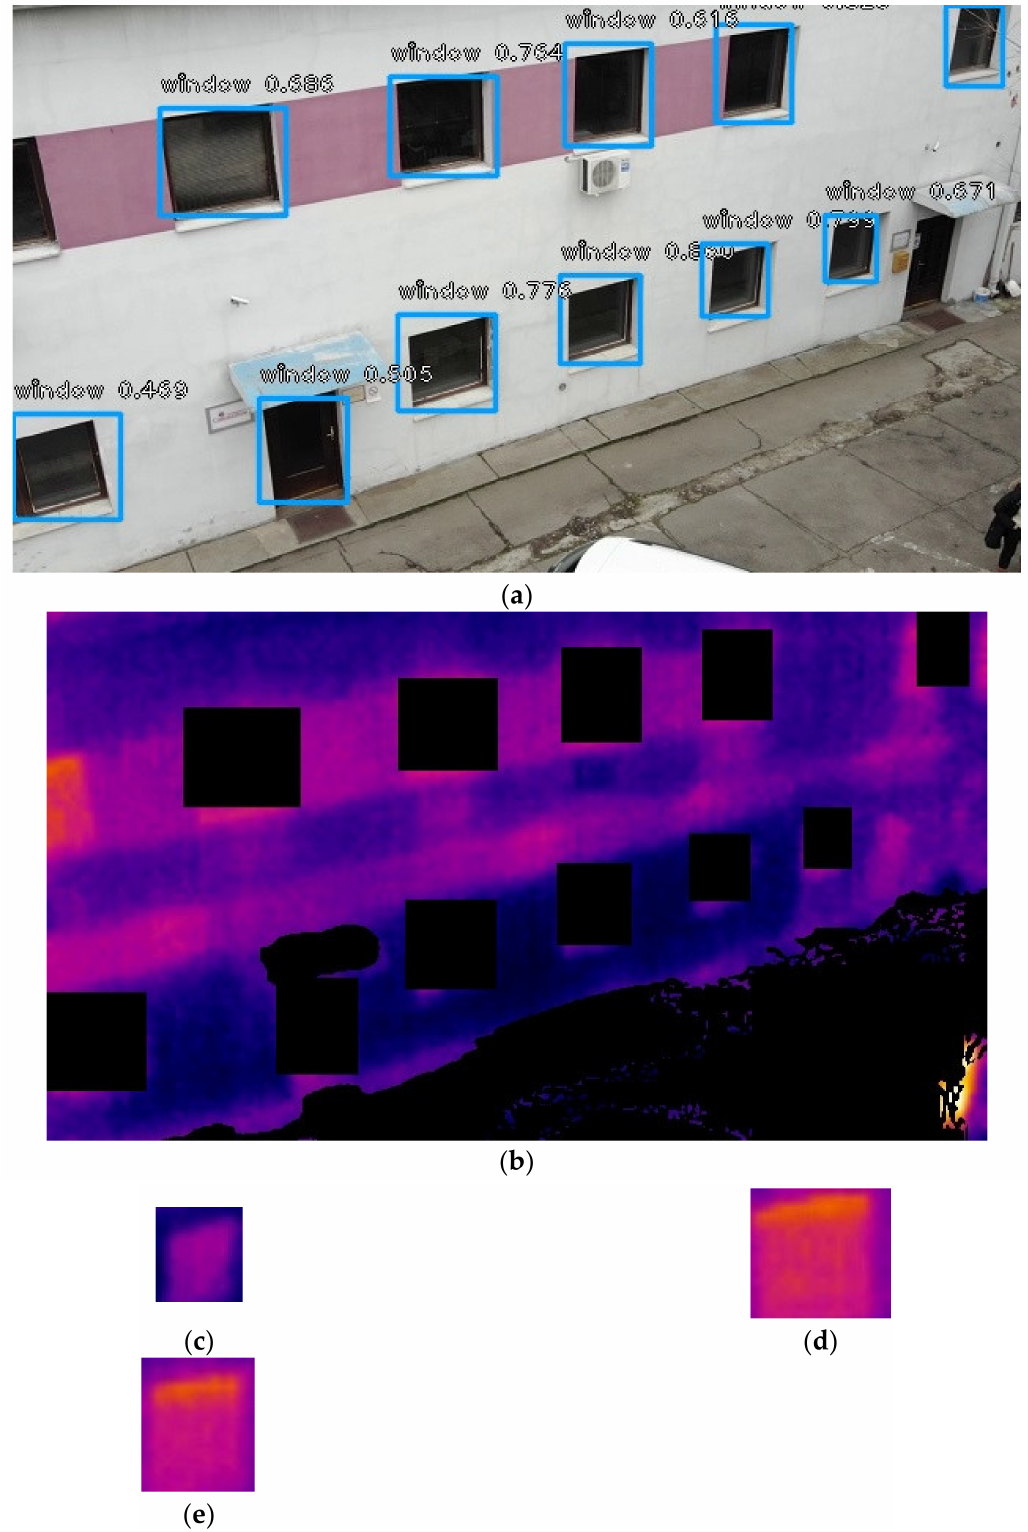
Figure 5. ( a ) Successfully detected windows on the construction; ( b ) IR image with windows and background removed; ( c – e ) extracted window